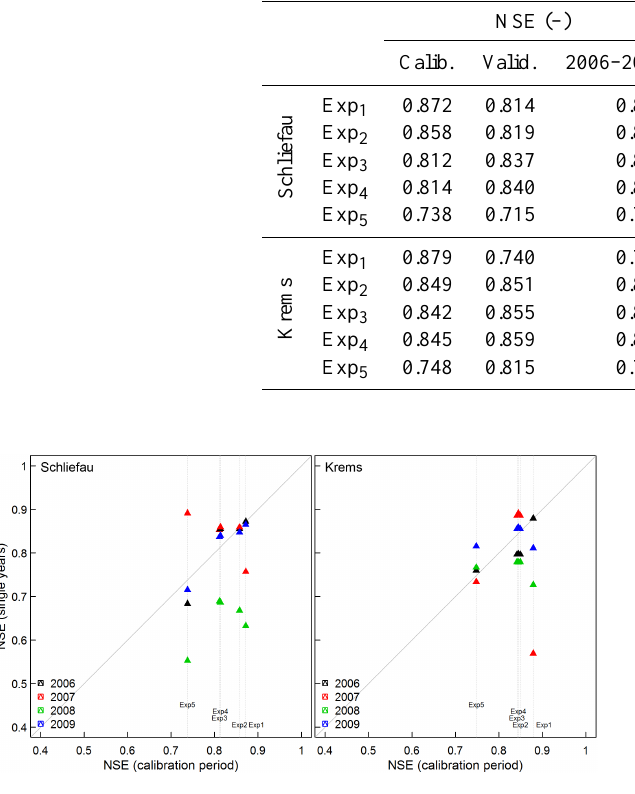
Figure 5. Nash–Sutcliffe efficiency (NSE) of the forward model for the calibration periods versus single years for the two study